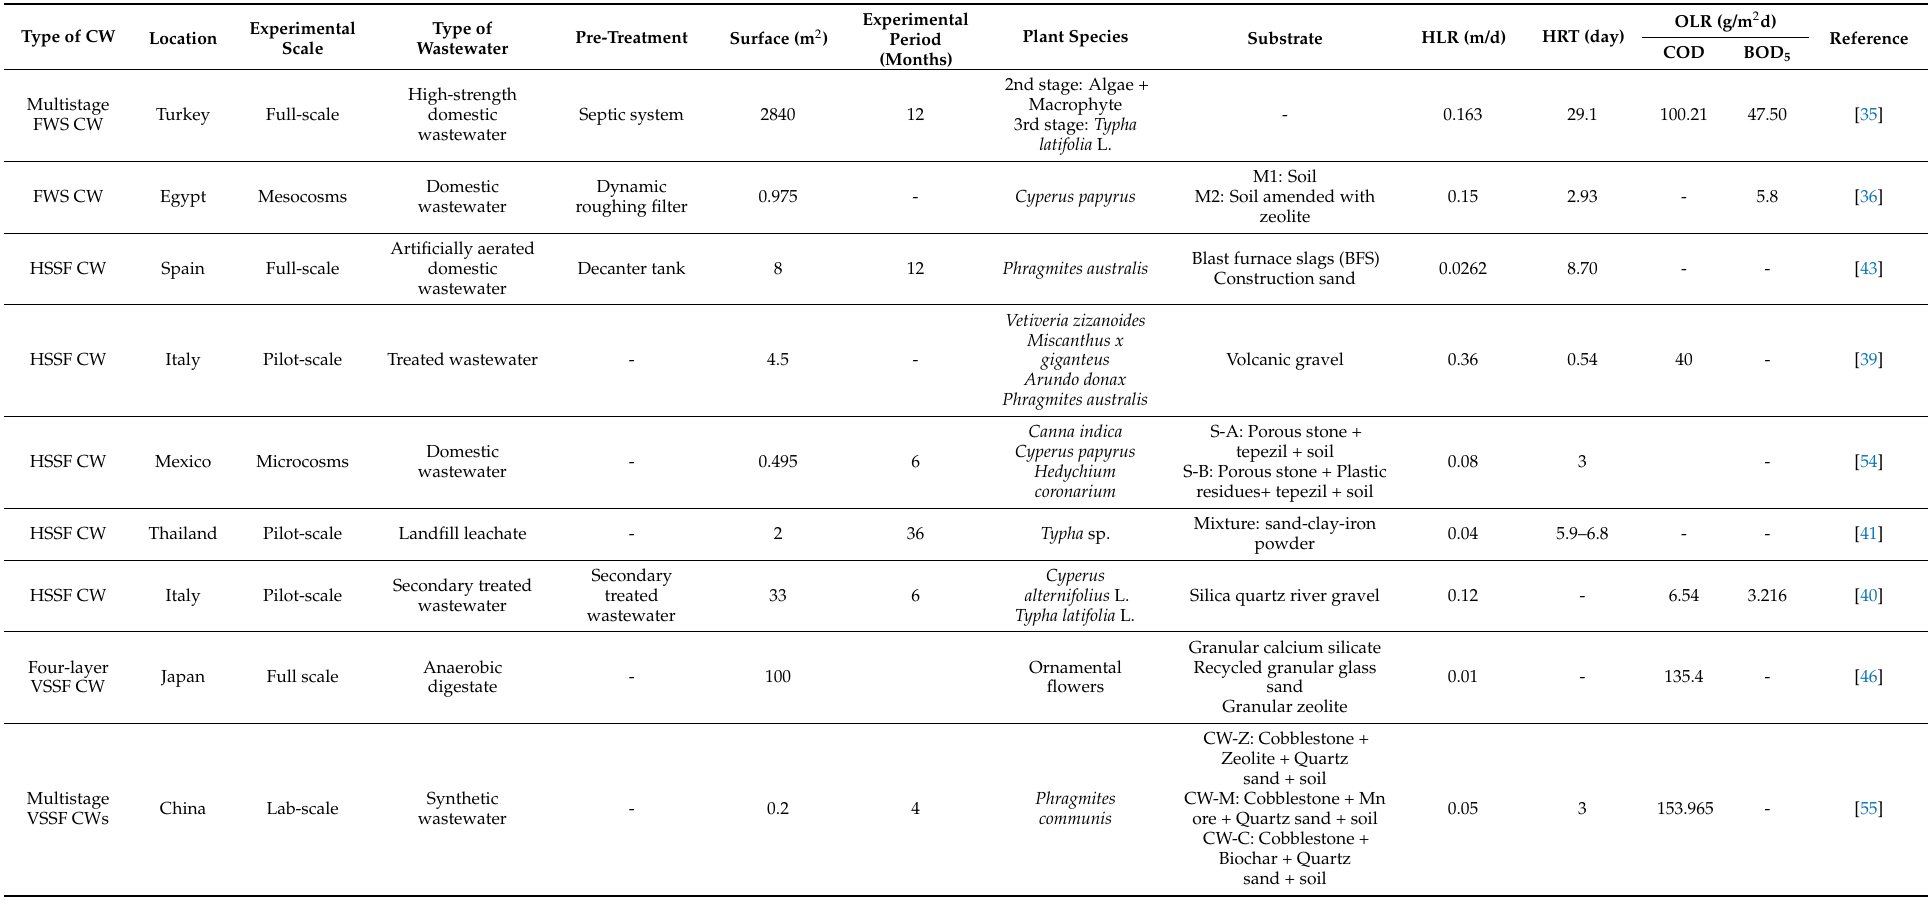
Table 1. Constructed wetland systems and their characteristics in terms of type, substrate and vegetation used, and operational